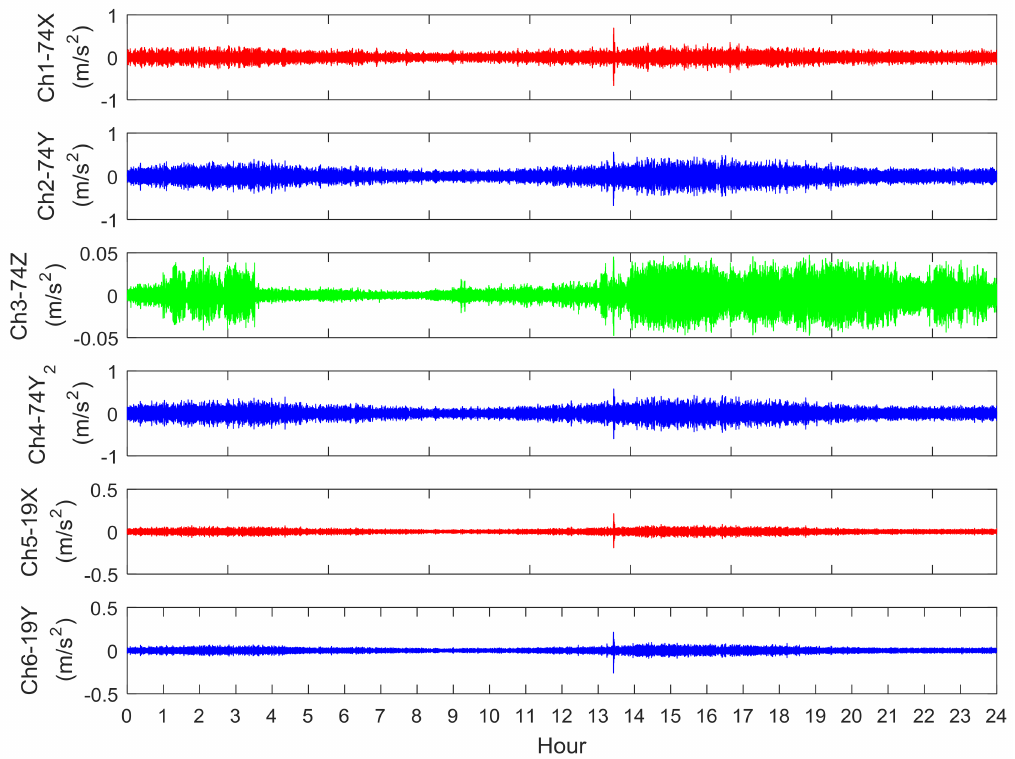
Figure 3. Time-series of acceleration data on 30 May 2016.